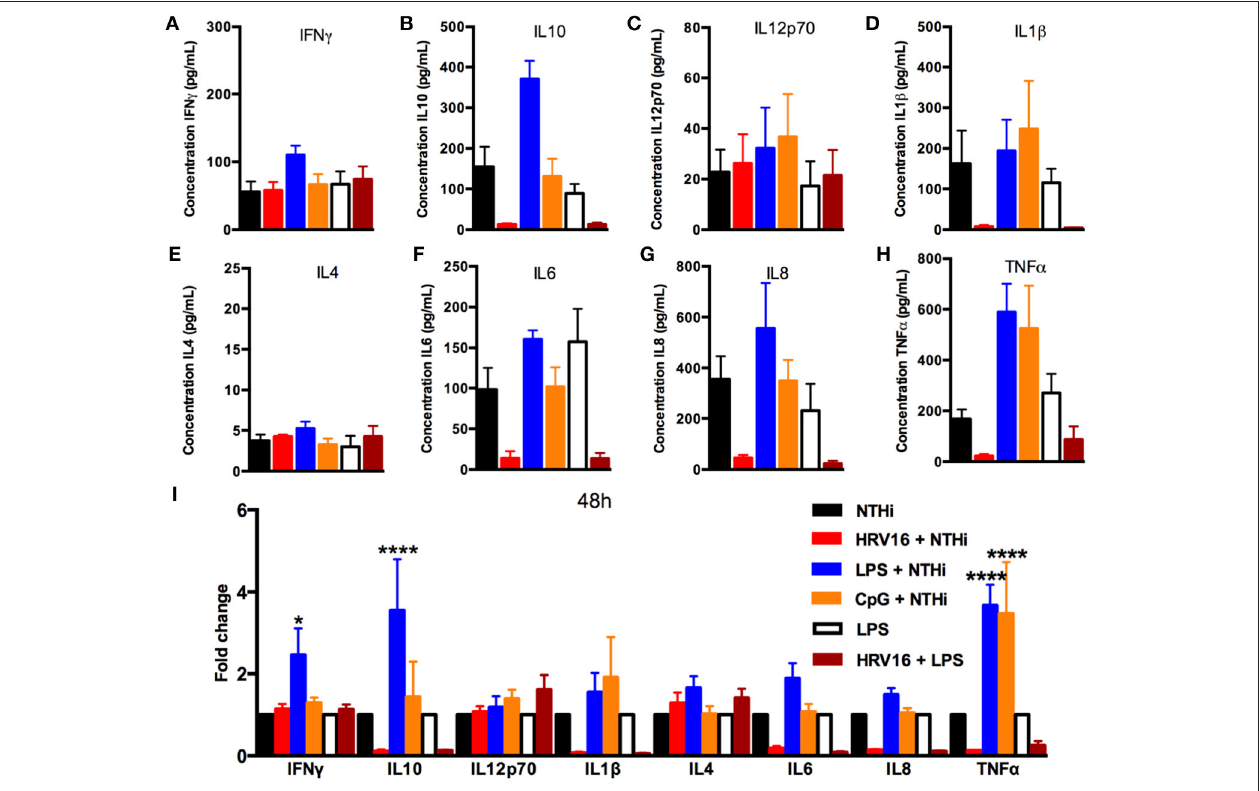
FIGURE 5 | Cytokine response of human macrophages exposed to HRV16 or TLR agonists for 48h and then challenged with NTHi or LPS. Human macrophages were exposed to HRV16 (red bars), LPS (blue bars), CpG (orange bars) or MI (black bars) for 1h and rested for 48h. Then they were exposed to NTHi or LPS for 2h and supernatants were collected and analyzed by MSD. MSD results for (A) IFN γ , (B) IL10, (C) IL12p70, (D) IL1 β , (E) IL4, (F) IL6, (G) IL8, (H) TNF α . (I) Relative fold changes for cytokine production in HRV16, LPS or CpG exposed human macrophages. * p < 0.05, **** p < 0.0001 Two Way Anova with Dunnett’s Post Test vs. NTHi or MI + LPS. Error bars represent standard error of the mean (SEM). n = 4 independent experiments on different donors.